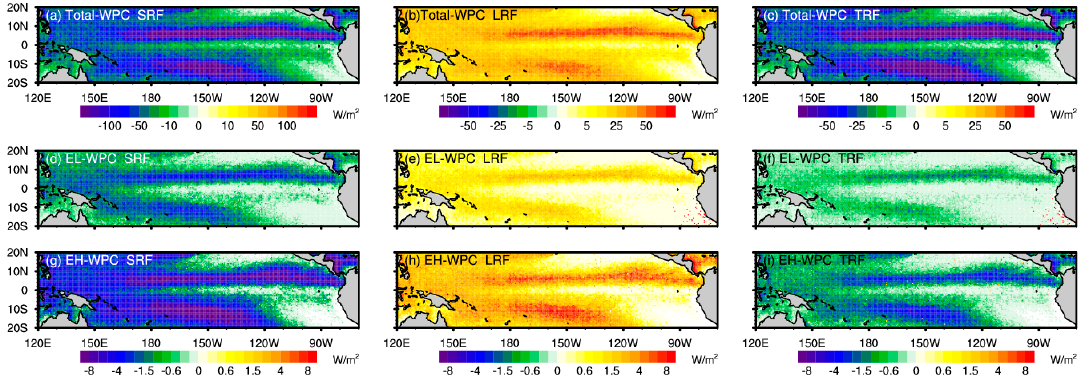
Figure 8. The ( a , d , g ) shortwave radiative forcing (SWCRF), ( b , e , h ) longwave radiative forcing (LWCRF), and ( c , f , i ) total radiative forcing (TCRF), for ( a – c ) total, ( d – f ) extreme-light, and ( g – i ) extreme-heavy warm precipitating cloud.